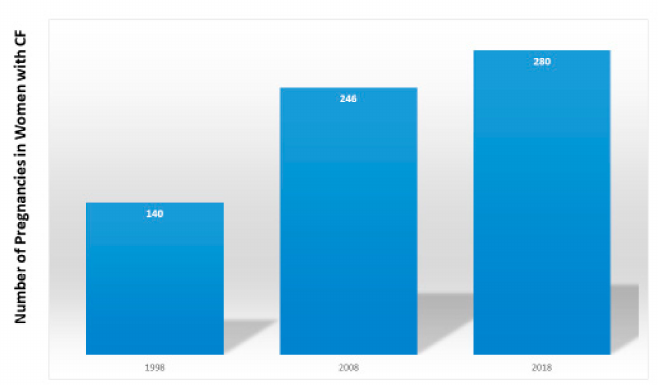
Figure 1. Number of pregnancies reported in the U.S. Cystic Fibrosis Foundation (CFF) Patient